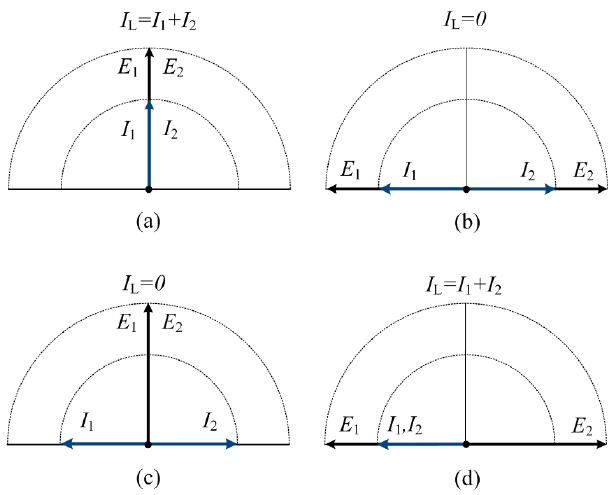
Figure 3. Voltage-current phase relationship of serial and parallel circuit. ( a ) +Sync in parallel circuit (large current); ( b ) − sync in parallel circuit (small current); ( c ) +sync in serial circuit (small current); and ( d ) − sync in parallel circuit (large current).